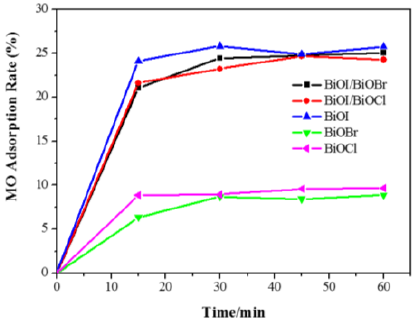
Figure 7. Adsorbed MO in the dark for BiOX (X = Cl, Br, I) and BiOI/BiOX (X = Br, Cl) composites ( C 0 = 20 ppm, catalyst dosage = 0.2 g/L).